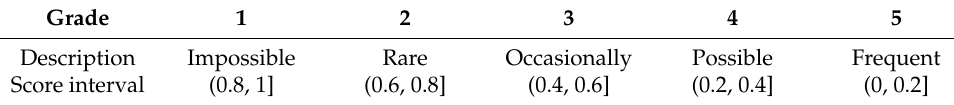
Table 2. Classification standard for engineering risk possibility.